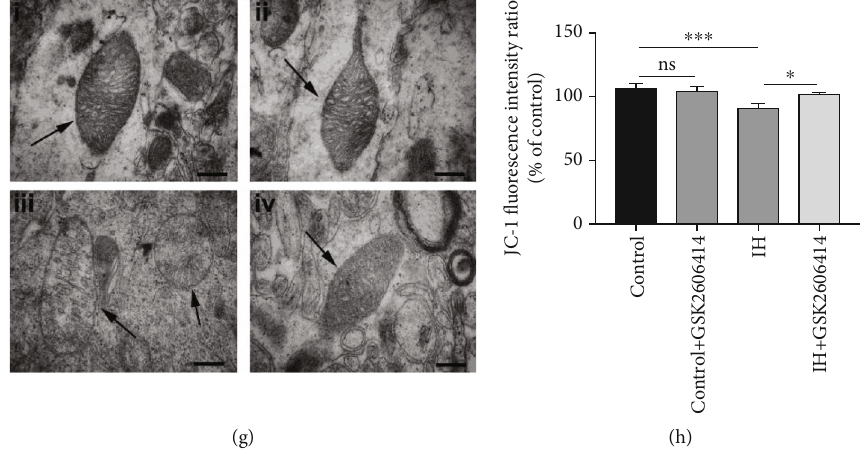
Figure 3: GSK2606414 reduced the activation of caspase-3 via mitochondria-dependent apoptosis. (a) Representative western blots showed that GSK2606414 reduced the expression of CHOP, Bim, and cleaved caspase-3 in hippocampal tissue. The pooled data from three mice for each group are summarized in (b). (c) The western blot results showed that the expression of Bax and Bak in the mitochondria was obviously increased and that this e ff ect was accompanied by a reduction in cytochrome c. These e ff ects were prevented by the administration of GSK2606414. (d) Statistical data from three animals for each group are summarized. (e) Representative western blots showing that the cytoplasmic expression of Bax and Bak was obviously reduced and that of cytochrome C was signi fi cantly increased. GSK2606414 increased the expression of Bax and Bak and reduced cytochrome C. (f) Statistical data from three animals for each group are summarized. (g) The morphology of mitochondria in the hippocampal CA1 region in the (i) control group, (ii) GSK2606414 group, (iii) IH group, and (iv) IH+ GSK2606414 group. In the control and GSK2606414 groups, intact mitochondria (indicated by arrowheads) with clear cristae were found. Much fewer cristae were found in the mitochondria from the IH group. GSK2606414 treatment preserved more intact mitochondria with discernable cristae. Scale bar: 0.25 μ m. (h) The mitochondrial membrane potential (JC-1 fl uorescence intensity ratio) was impaired by IH treatment and rescued by GSK2606414 treatment. ∗ P < 0 : 05 ; ∗∗ P < 0 : 01 ; ns: not signi fi